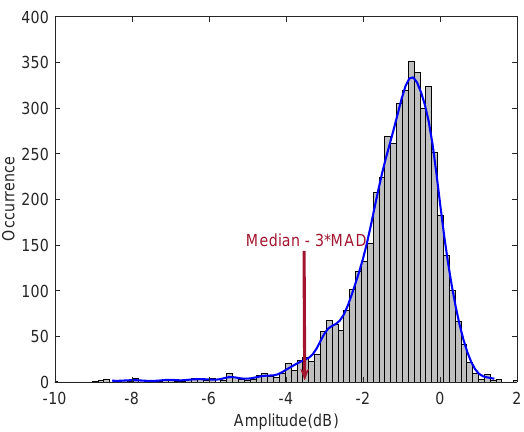
Figure 7. Histogram of the GPR data of sound